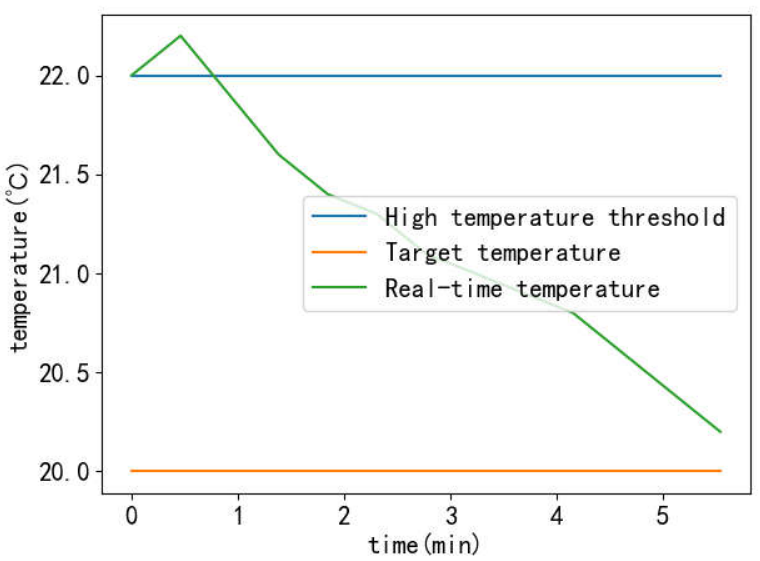
Figure 13. Comparison of the adjustment effect. The X-axis represents the date, and the Y-axis rep- resents the total amount of time that the temperature is abnormal each day.